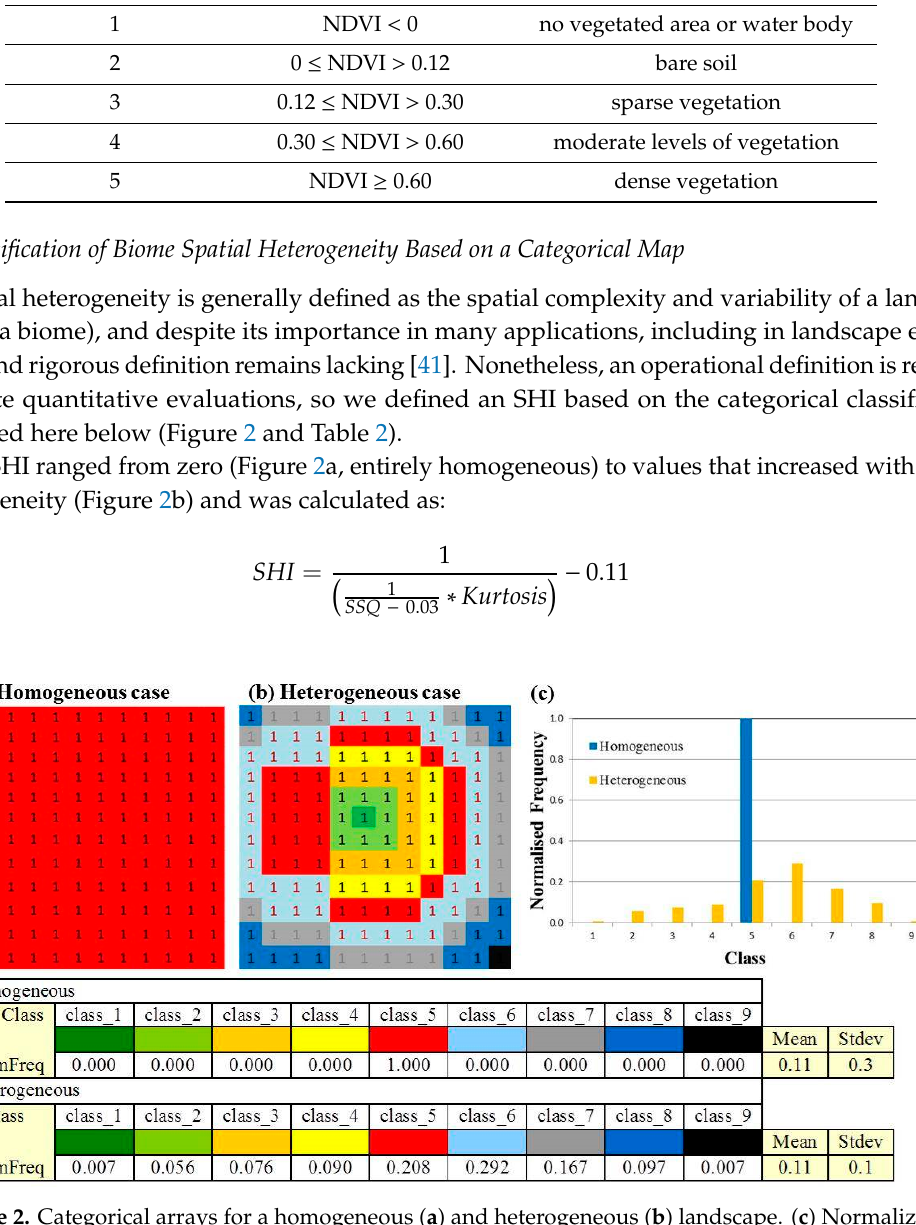
Figure 2. Categorical arrays for a homogeneous ( a ) and heterogeneous ( b ) landscape. ( c ) Normalized frequency distributions for the homogeneous and heterogeneous arrays of pixels. The table shows the classes and corresponding normalized frequencies (NormFreq) for the nine classes in the pixel array of the homogeneous and heterogeneous landscapes (Stdev: Standard deviation). Table 2. Sum (SUM), sum squared (SSQ), kurtosis and spatial heterogeneity index (SHI) for the categorical arrays of the homogeneous and heterogeneous landscapes in Figure 2.